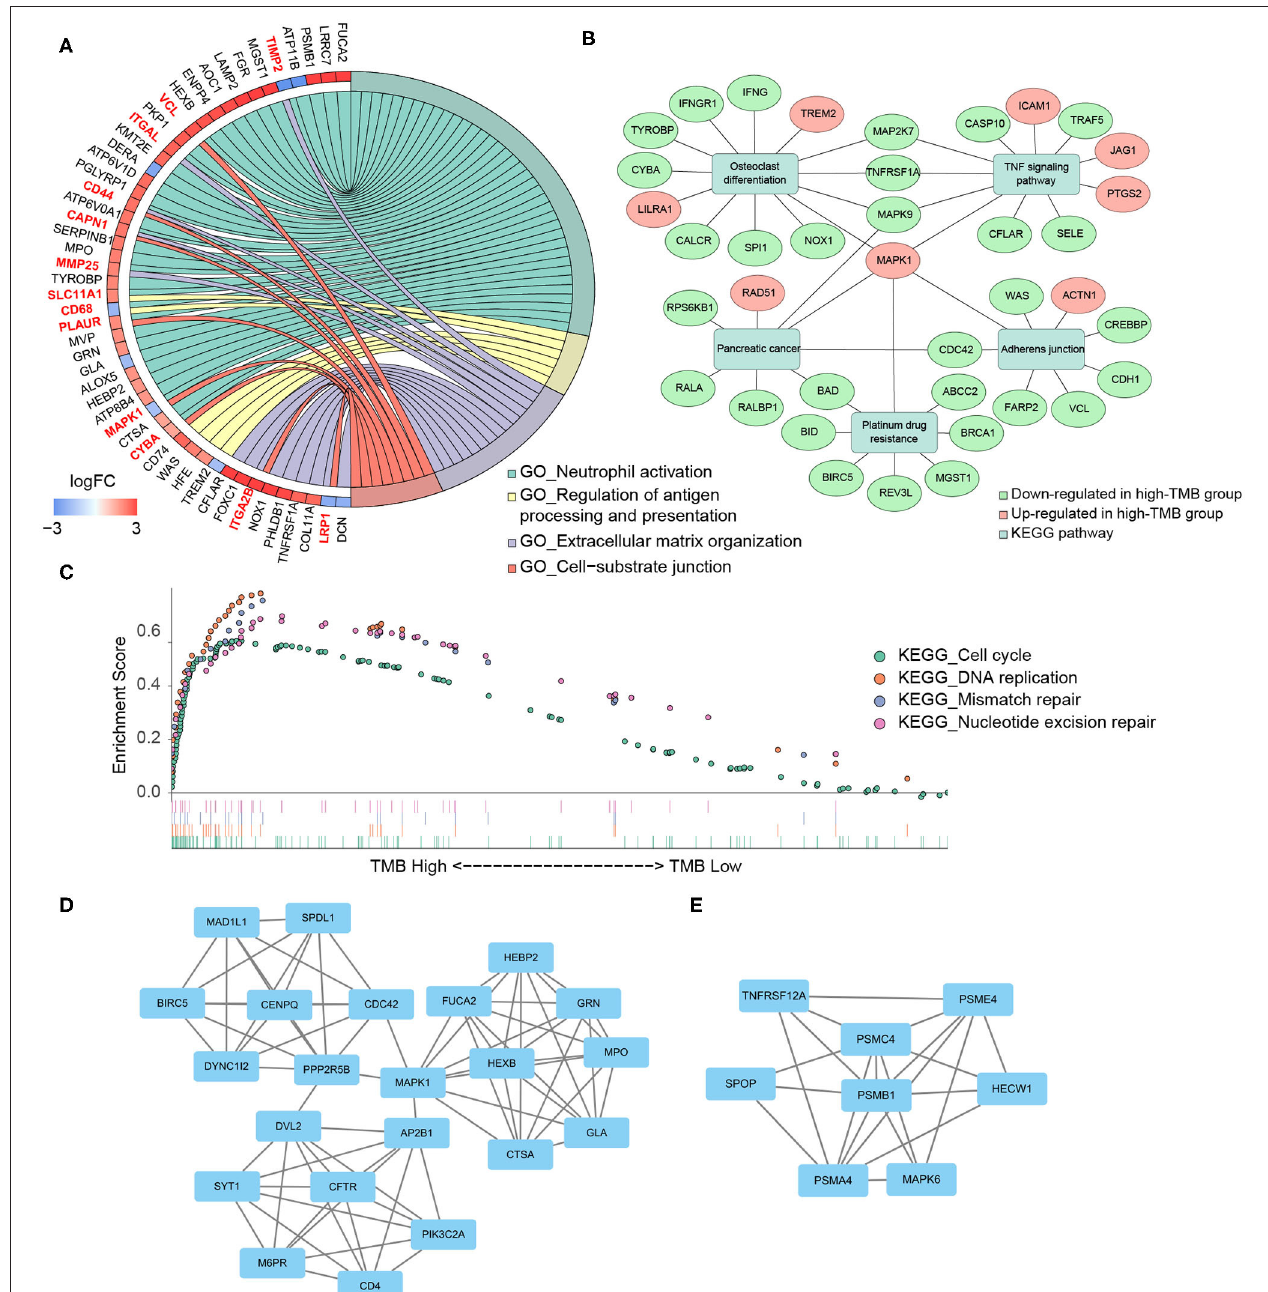
FIGURE 4 | Functional enrichment analysis and PPI subnetworks. (A) Chord diagram further exhibited the relationship between DEGs and GO pathways. (B) MAPK1 gene played a critical role in multiple significant KEGG pathways. (C) TMB-related pathways, explored by GSEA, including cell cycle, DNA replication, mismatch repair, and nucleotide excision repair, with FDR < 0.025. (D,E) Two significant subnetworks of PPI